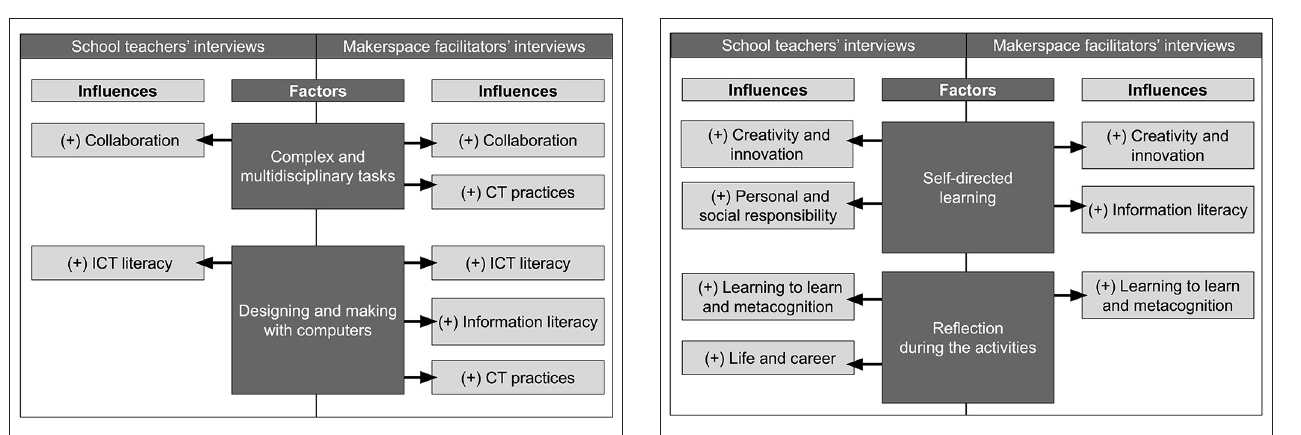
FIGURE 2 | The factors regarding facilitation of the activities and their positive influence ( + ) on learning 21st century skills and CT